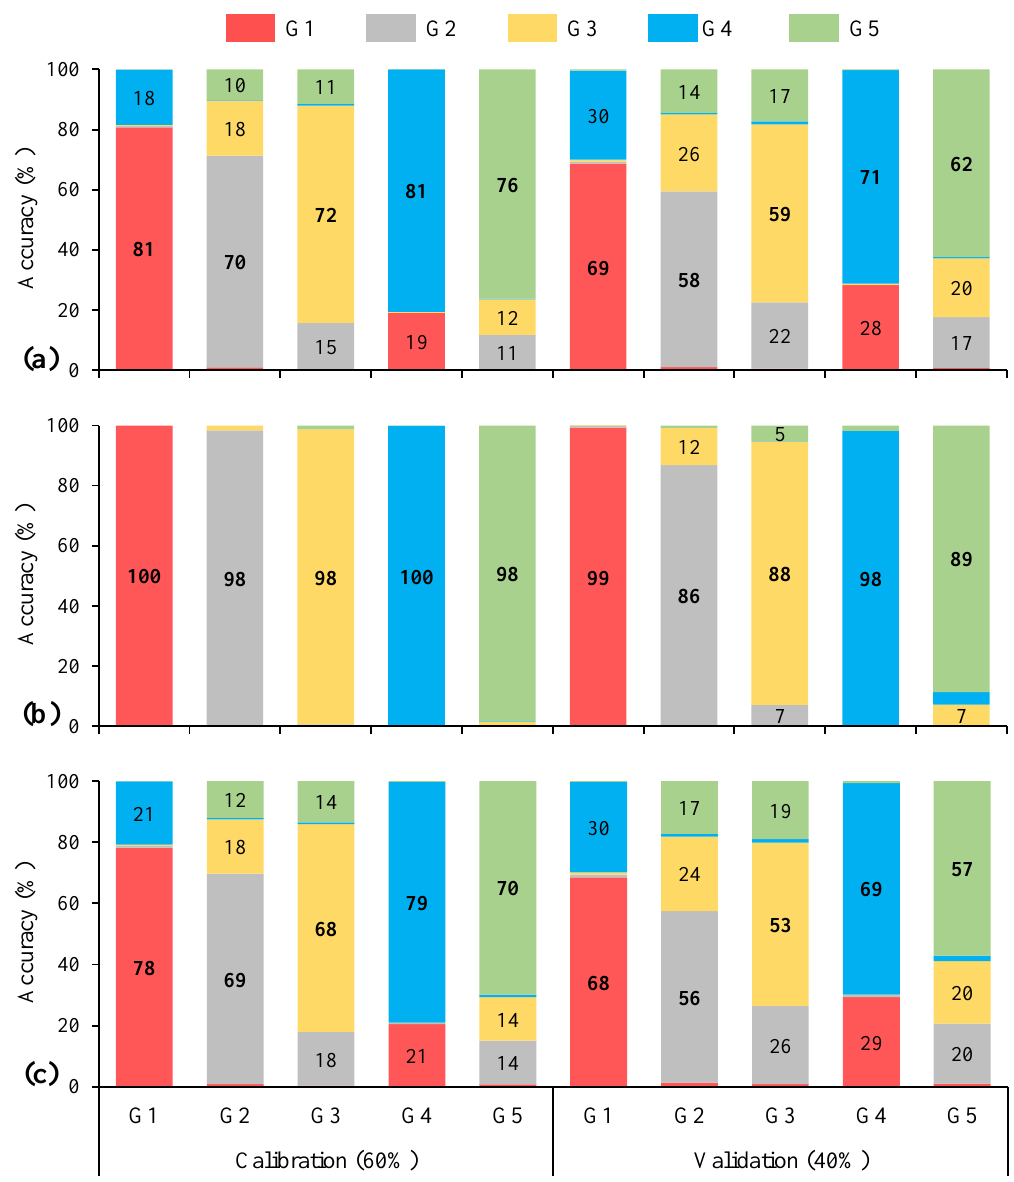
Figure 11. Linear discriminant analysis of Embrapa 2016 – 2019 ( a ), Unoeste 2018/2019 [I] ( b ), and Embrapa 2016 – 2019 + Unoeste 2018/2019 [I] ( c ) spectral datasets: percentage of accuracy in the spectral classification of each genotype (bar) relative to all genotypes (colors within the bar) for calibration and validation approaches.